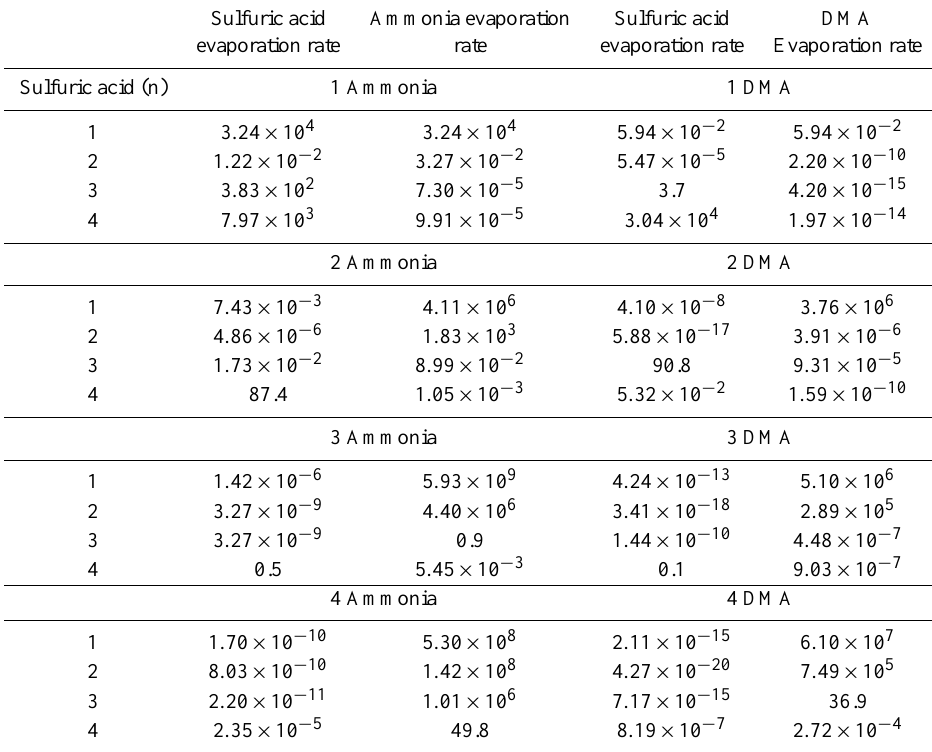
Table 4. Evaporation rates (1s − 1 ) for different clusters included in this work.